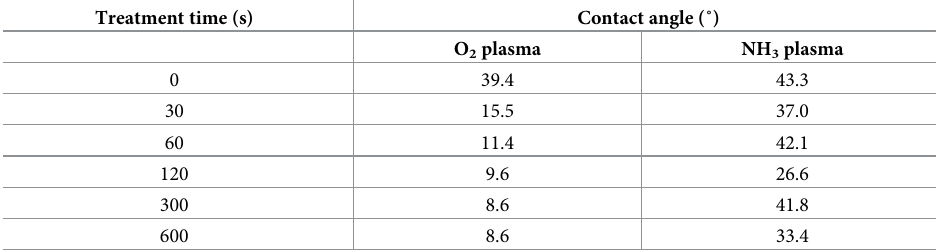
Table 1. Contact angles of water droplets on ammonia and oxygen plasma-treated Ni film for different treatment